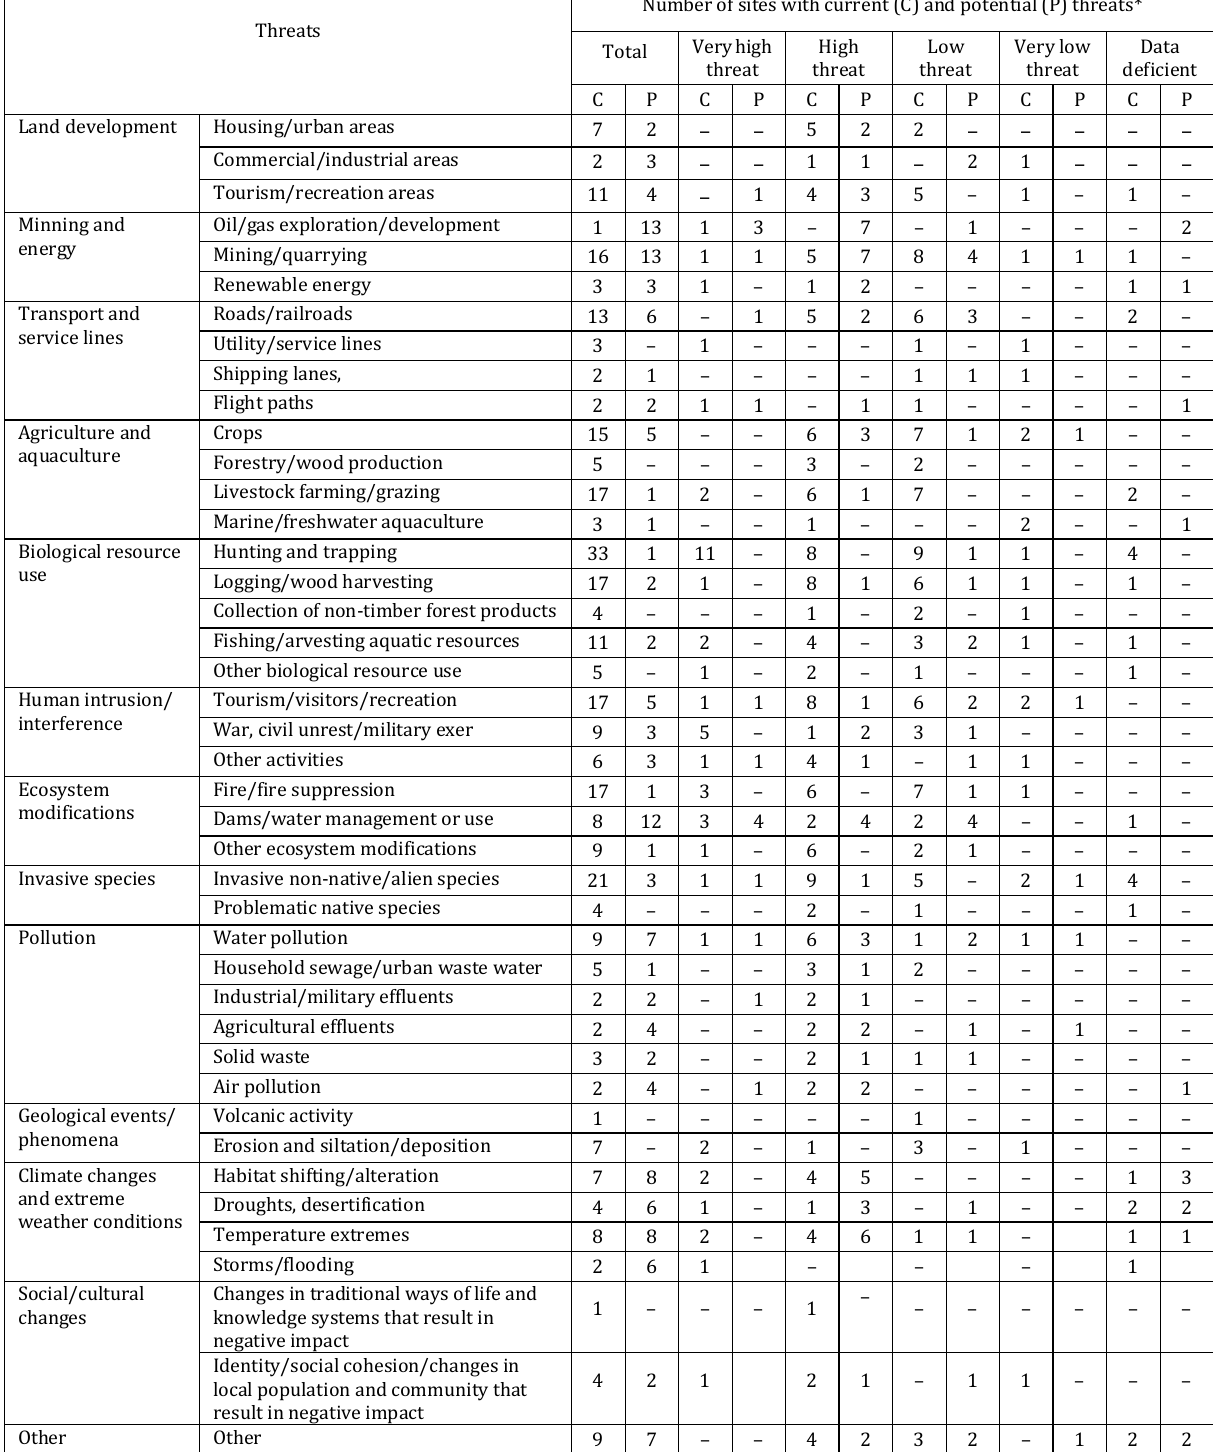
Table 4. Current (C) and potential (P) threats in natural and mixed World Heritage sites in Africa